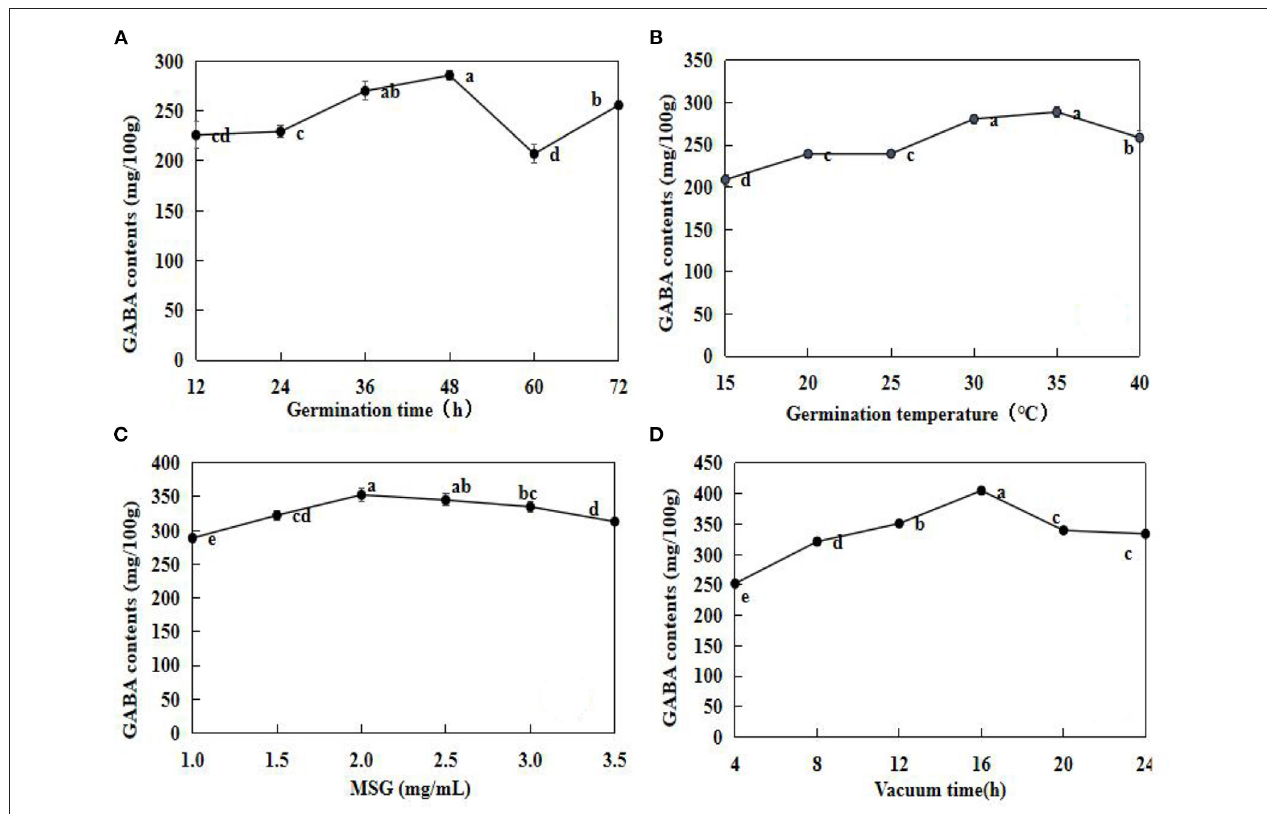
FIGURE 2 | Effects of germination time (A) , germination temperature (B) , monosodium glutamate (MSG) concentration (C) , and vacuum time (D) on GABA contents in adzuki bean. After pre- soaking treatments, the beans were subjected to germination experiments. Effect of germination time was tested at 25 ◦ C (A) ; Effect of germination temperature for 24h (B) ; Effect of MSG concentration was tested at 25 ◦ C and for 24h (C) ; Effect of vacuum time was tested 25 ◦ C and 24h (D) . The data are mean ± SD ( n = 3). Different lowercase letters indicate significant differences at p <